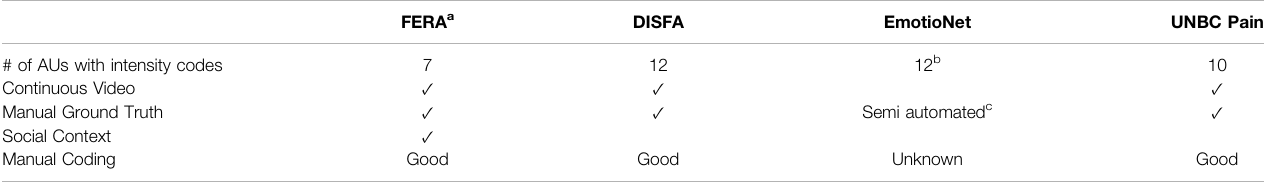
TABLE 1 | Comparison of AU intensity